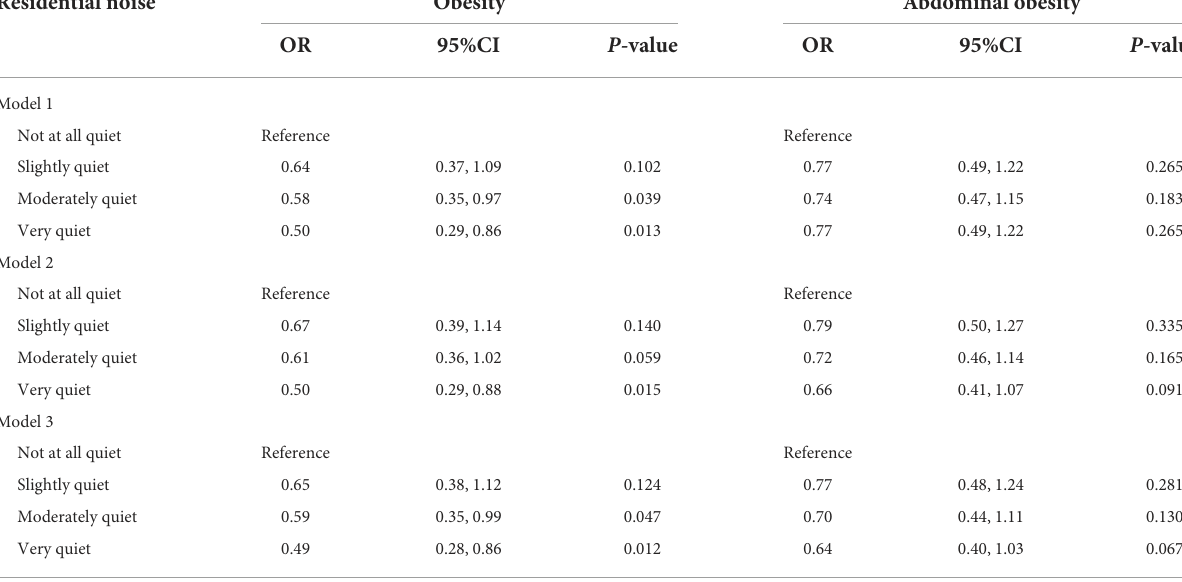
TABLE 2 Associations of self-reported noise exposure with obesity and abdominal